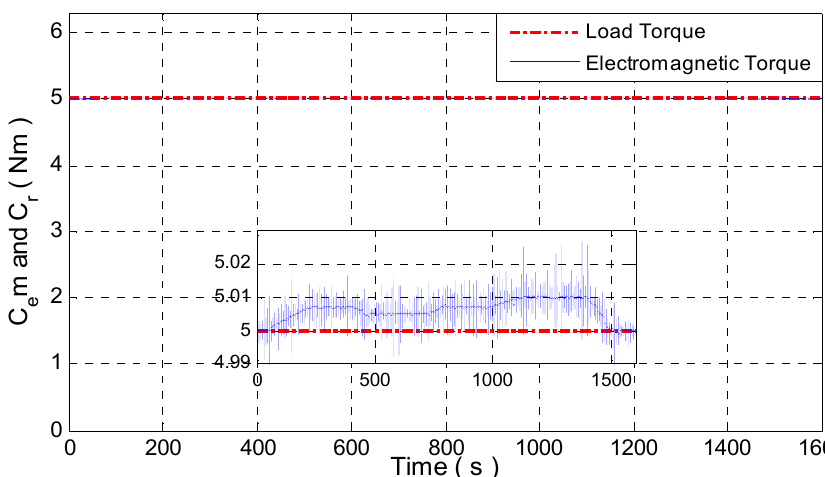
Figure 3. Load torque and electromagnetic torque, with zoom.